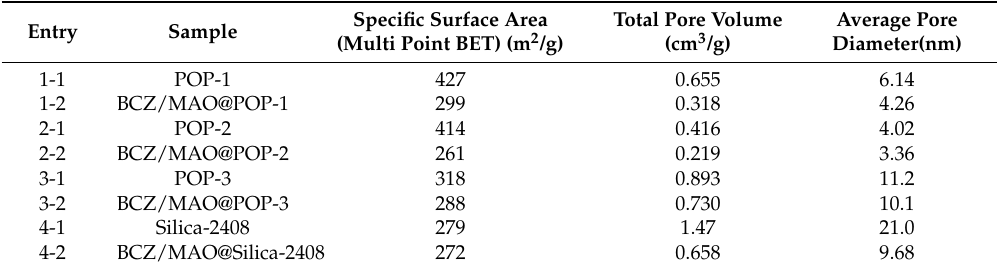
Table 1. Characterization data of P(HEMA-co-DVB) particles and ( n -BuCp) 2 ZrCl 2 /MAO/POPs